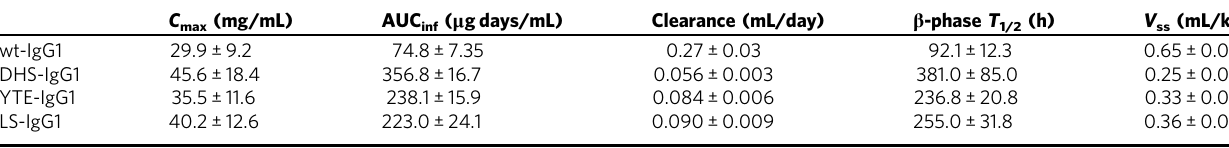
Data are presented as mean±standard deviation ( n =